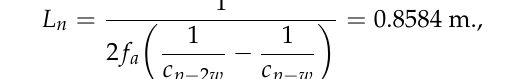
Figure 5. Magnitudes of the S 1 -S 2 mode pair (3.534–7.068 MHz mm) extracted through STFT in the 2-D simulation model ( a ) fundamental mode A1; ( b ) second harmonic mode A2, and ( c ) A2/(A1) 2 .